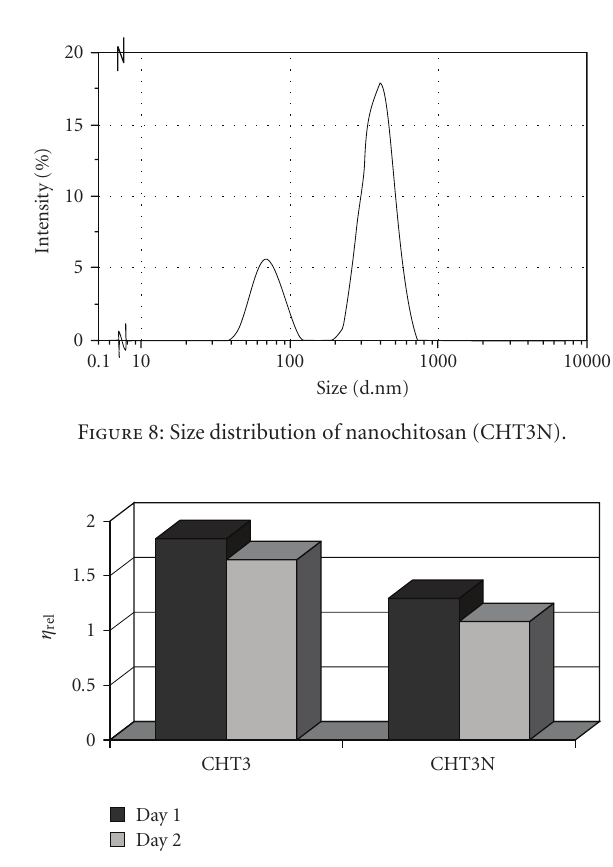
Figure 9: Relative viscosity of chitosan solution as a function of particle